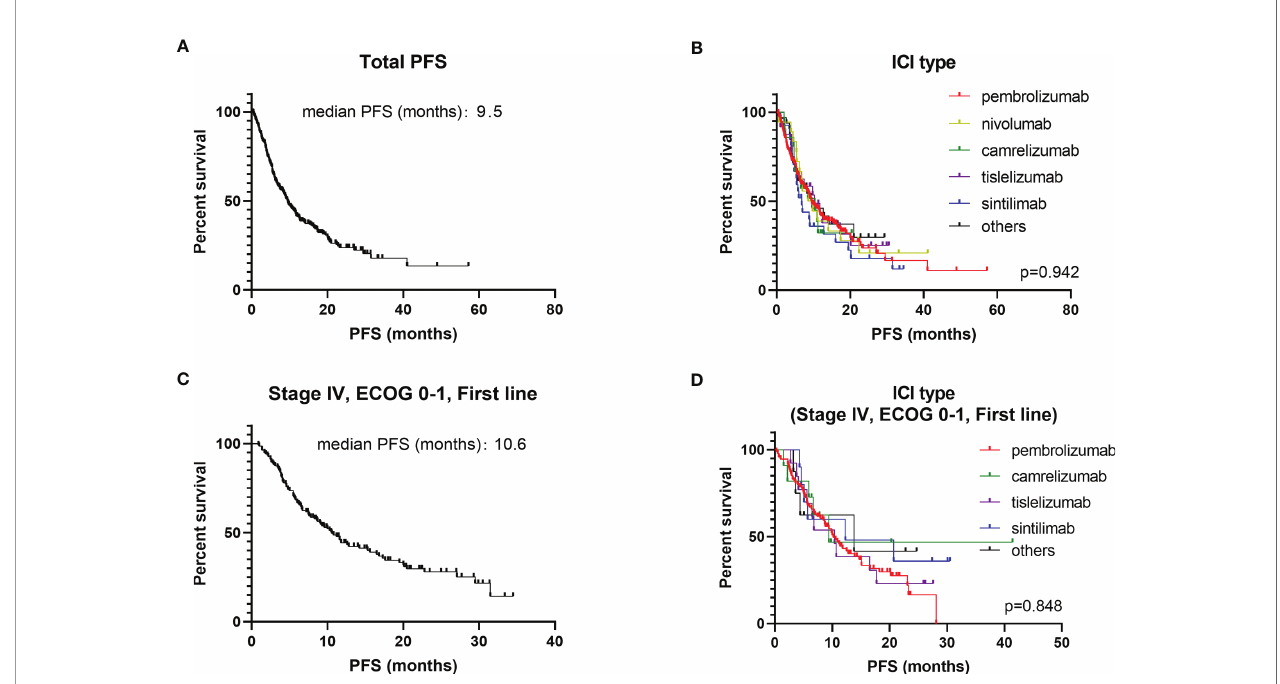
FIGURE 1 | Kaplan-Meier plot of PFS for different ICIs. (A) PFS for all NSCLC patients; (B) strati fi ed according to different ICIs (all NSCLC patients); (C) PFS for stage IV, fi rst line, ECOG 0 – 1 patients; (D) strati fi ed according to different ICIs (stage IV, fi rst line, ECOG 0 – 1 patients).